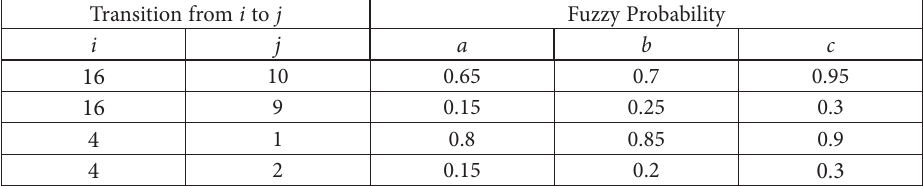
Table 9. Fuzzy probabilities Transition from i to j